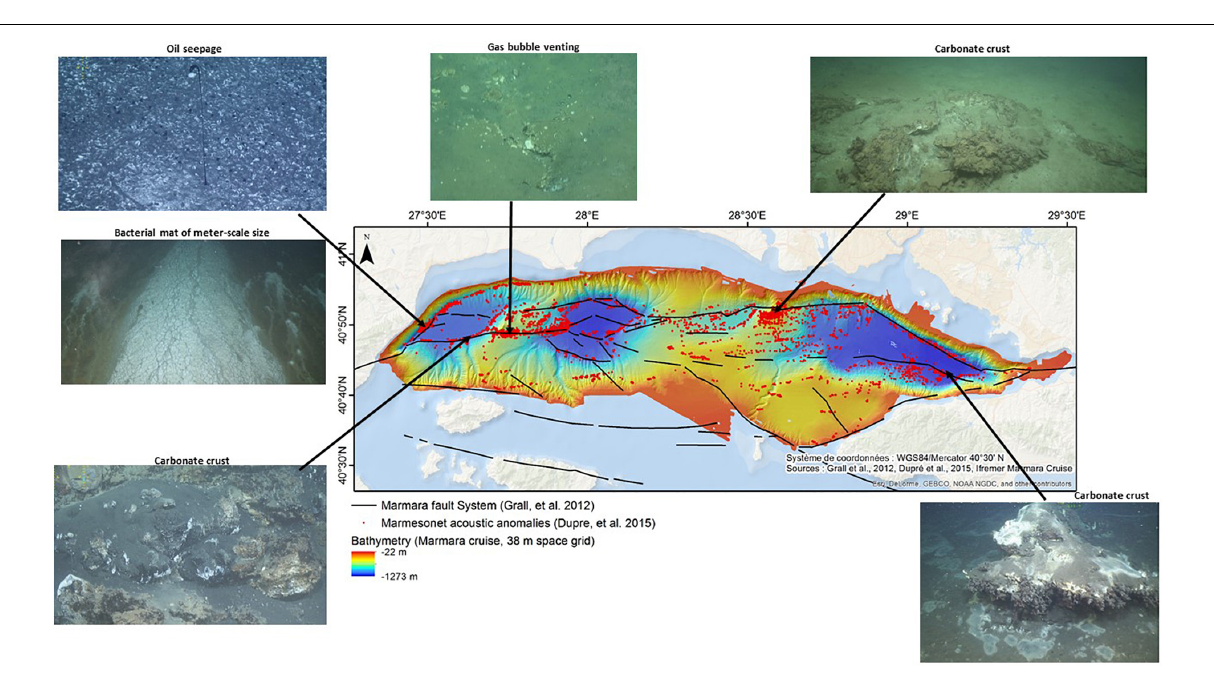
FIGURE 11 | Bathymetric map of the Sea of Marmara highlighting the link between structural features and gas emissions [data from Grall et al. (2012, 2018a), Ruffine and Geli (2014), Dupré et al. (2018)]. A large variety of carbonate crusts and seeps (oil and gas) are widespread along the fault network. Fluid discharge sustains the development of bacterial mats at the